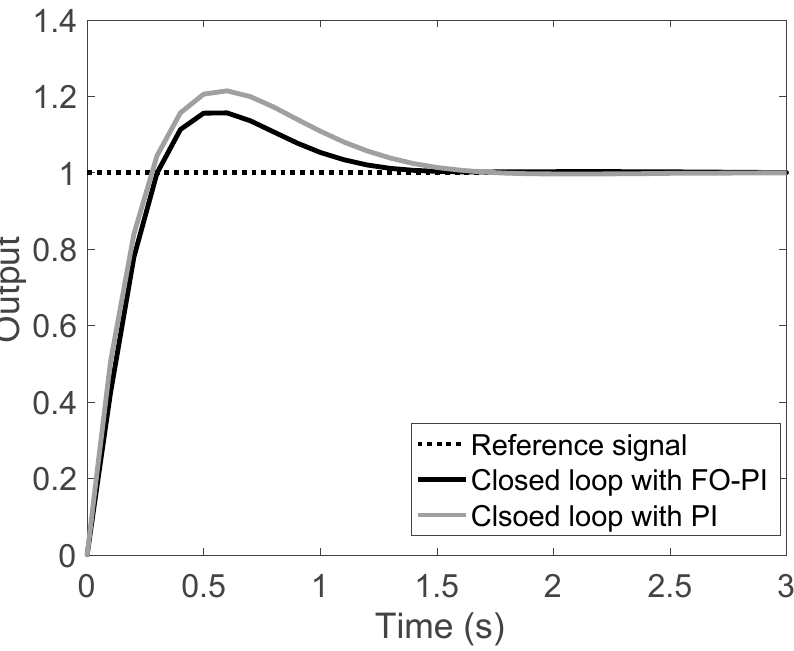
Figure 8. Comparative reference tracking results for a simple first-order system.